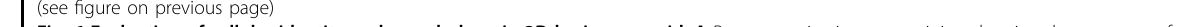
Fig. 6 Evaluation of cellular identity and morphology in 3D brain organoid. A Representative immunostaining showing the presence of a N- CADHERIN-positive (green) germinal layer in correspondence of the apical membrane of the ventricular zone layer in a FMRP-WT brain organoid at day 50. B , C Representative images revealing forebrain progenitor markers in developing cortical plates within FMRP-WT brain organoid at day 50: B SOX2 (green), DAPI (blue); C PAX6 (red), FOXG1 (green) and DAPI (blue). D Representative staining of early-born deep-layer cortical neurons positive for TBR1 (red), CTIP2 (green) markers, and pan-neuronal MAP2 marker (white) in a FMRP-WT brain organoid at day 50. E Representative images of a cortical plate from a FMRP-WT brain organoid at day 100 revealing heterogeneous cellular population, labeled for speci fi c cortical neuronal marker (CTIP2, green), astrocytic marker (GFAP, red), and neuronal progenitor marker (PAX6, white). Nuclei were stained with DAPI (blue). Scale bar: 100 μ